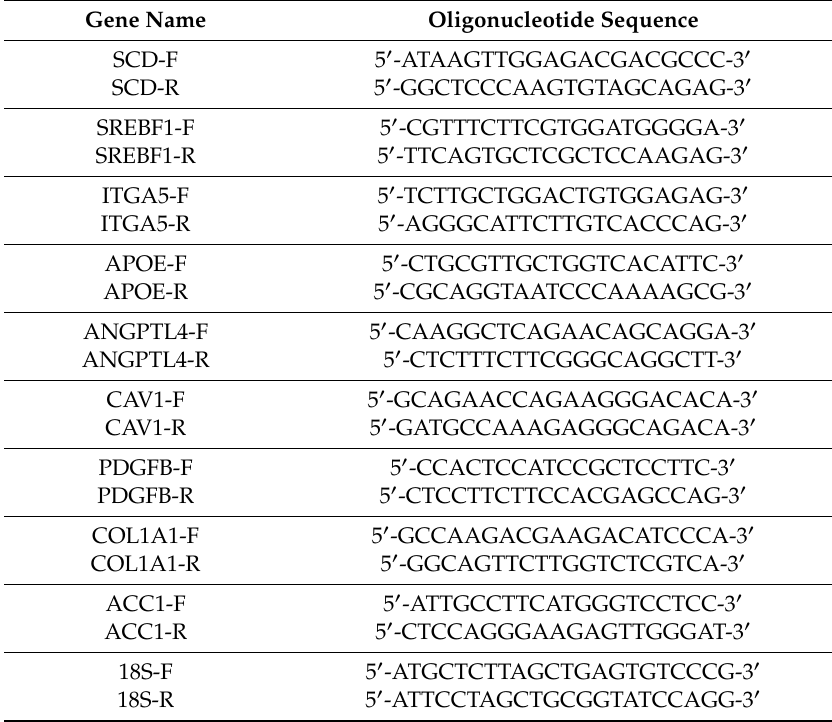
Table 1. List of primers used in this